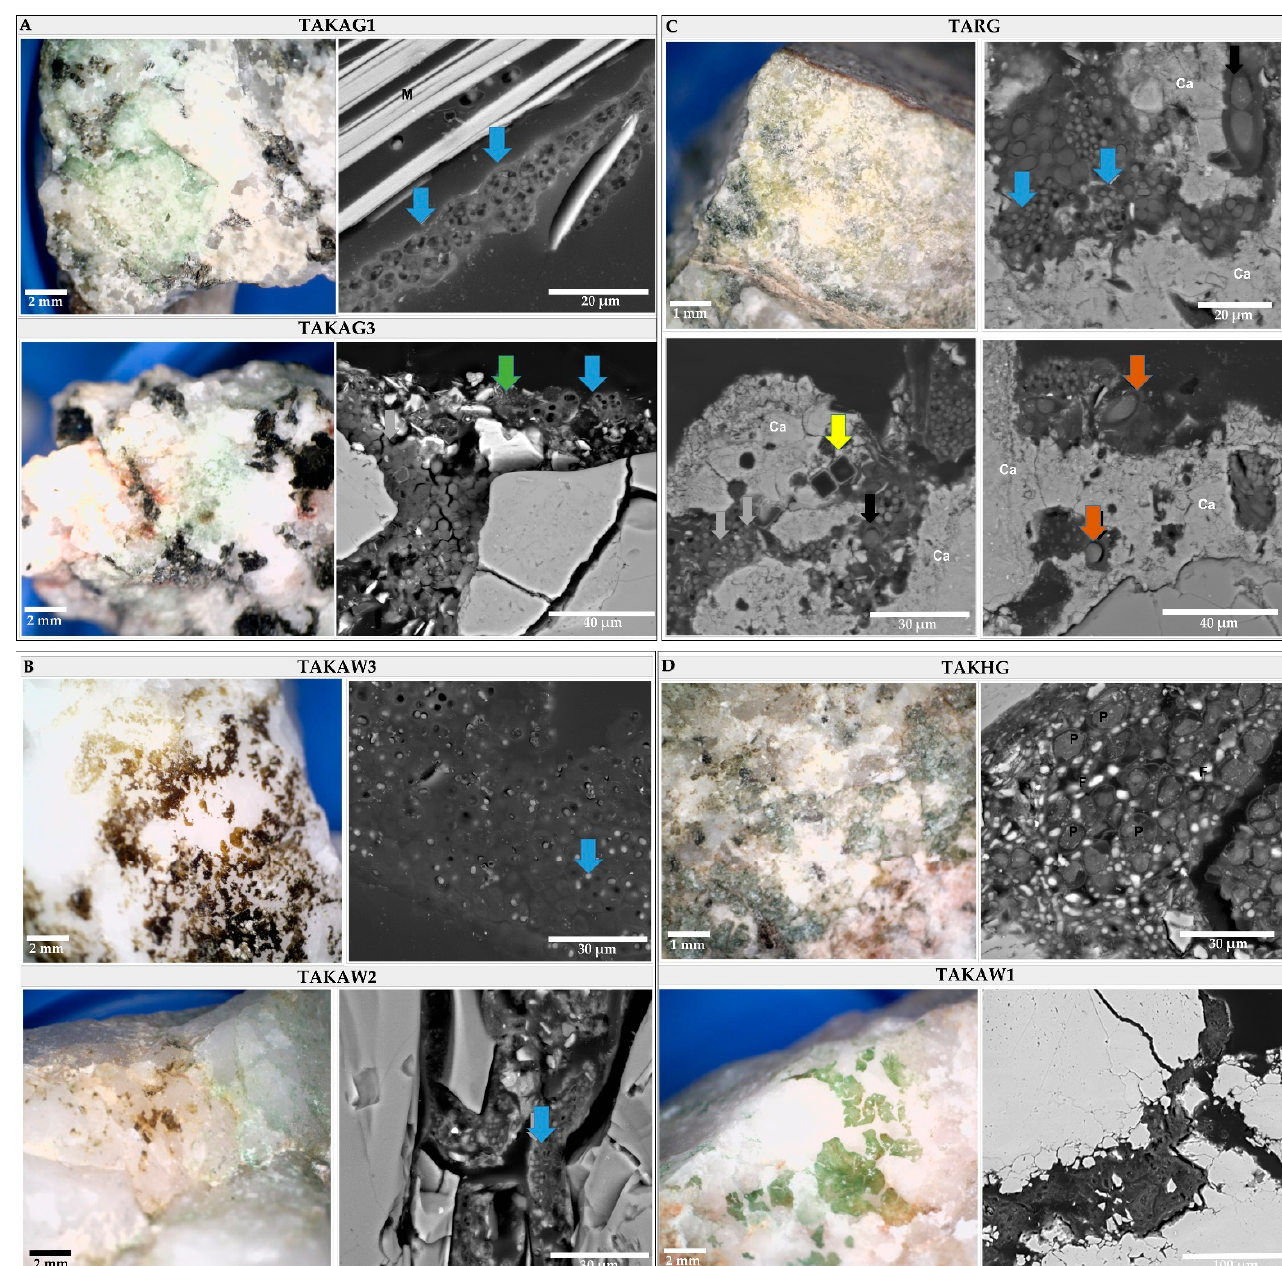
Figure 7. The top view of endolithic biofilms of the broken rocks and cross-sections of studied rock samples. ( A ) Cyanobacteria-dominated biofilm (TAKAG1 and TAKAG3) with coccoid cyanobacteria forming packets colonized mica (blue arrow) and smaller bacterial cells (green arrow). ( B ) Cryptoendolithic communities inhabiting quartzites are mainly represented by package-forming coccoid cyanobacteria (blue arrow). ( C ) Euendolithic community inhabiting Ca-rich layer (Ca), composed of different cyanobacterial morphotypes including coccoid (blue arrows) and filamentous, non-heterocystous cyanobacteria (brown arrows), and diatoms (yellow arrow). ( D ) Cross-sections of lichen-dominated biofilms (TAKHG, TAKAW1).